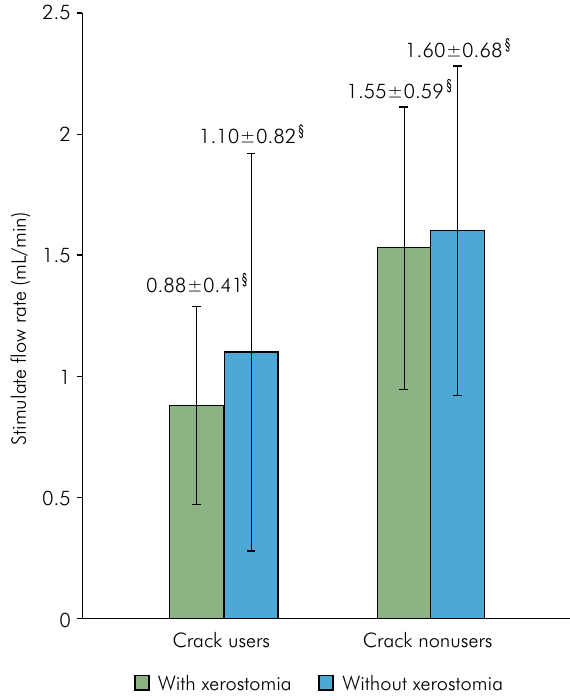
Figure 1. Association between xerostomia and stimulated salivary flow in crack users and non-users (§ Mean ± standard